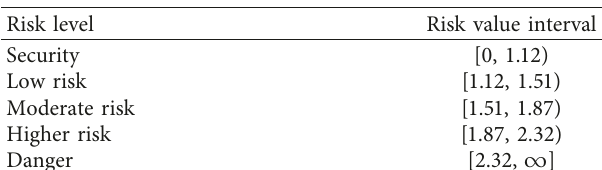
Figure 9: Silhouette coefficient under different cluster numbers. Table 8: Risk